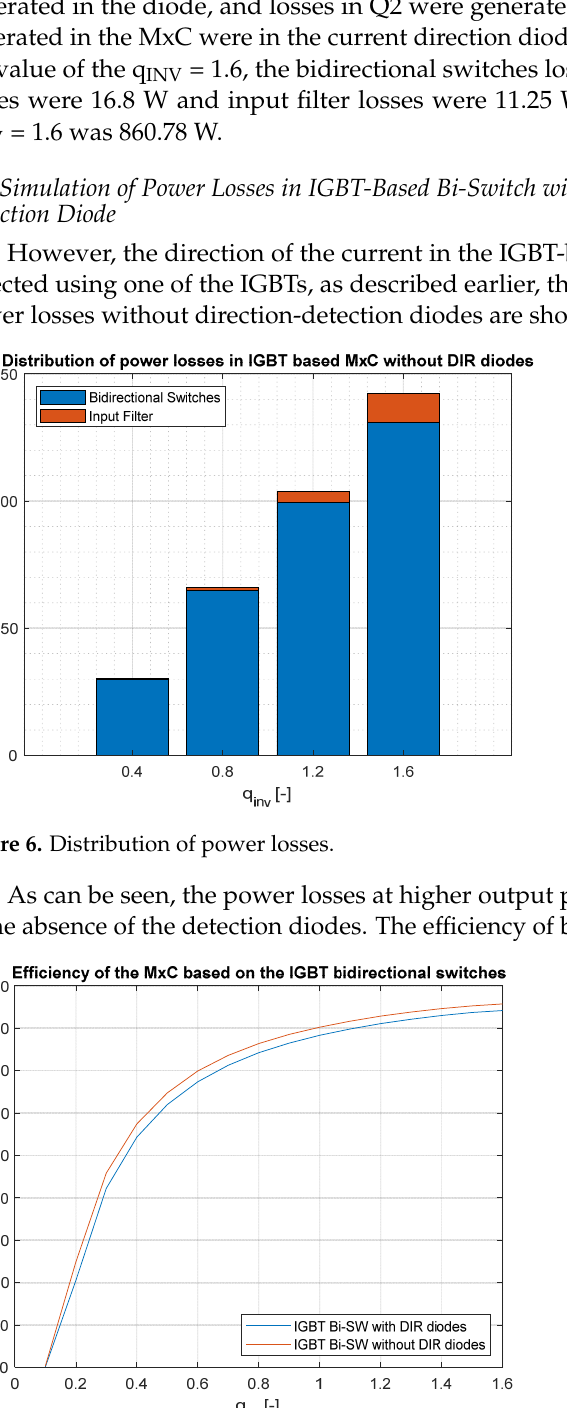
Figure 5. Instantaneous power losses in bidirectional switch.